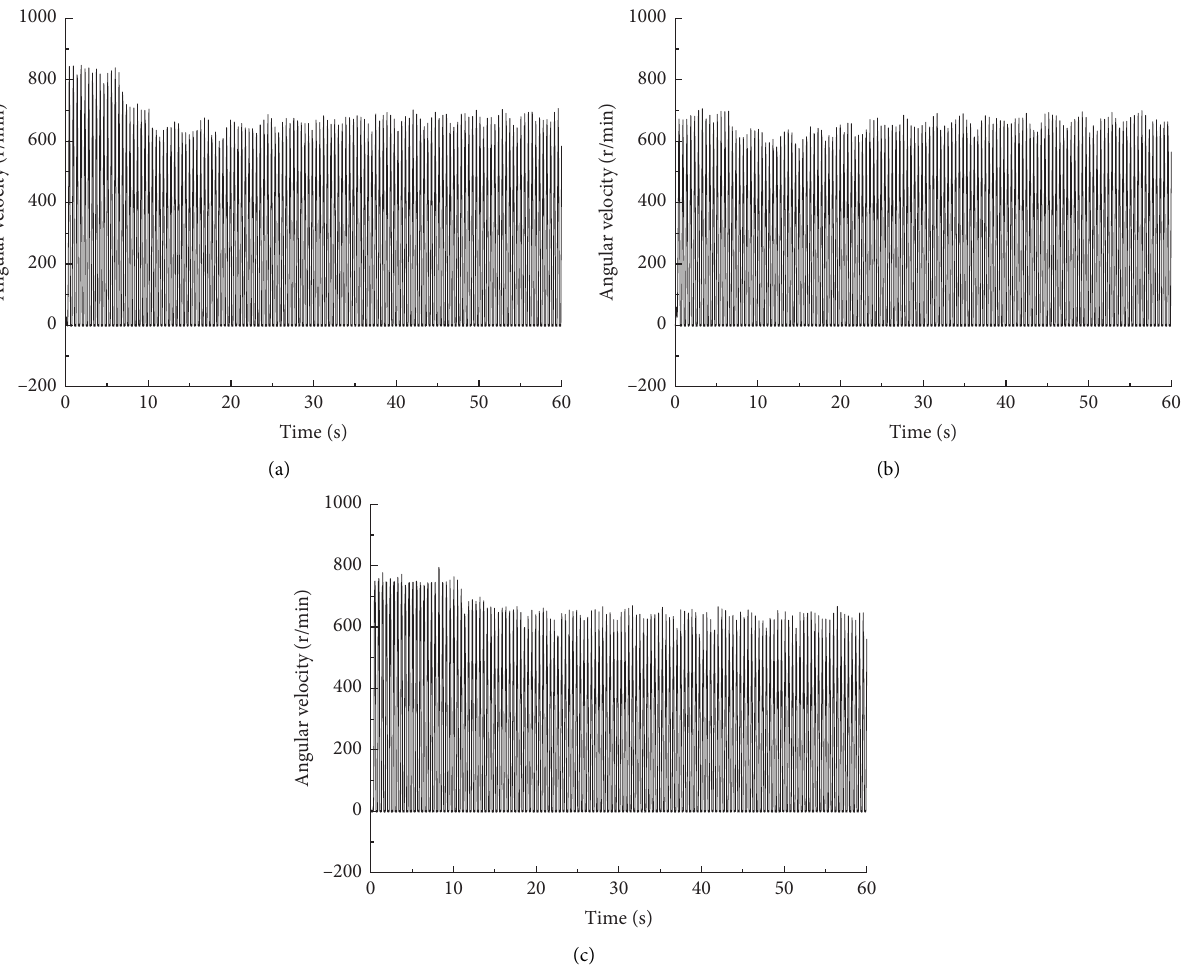
Figure 14: Angular velocity for various axial loads: (a) 0.5kgf; (b) 1.5kgf; (c)